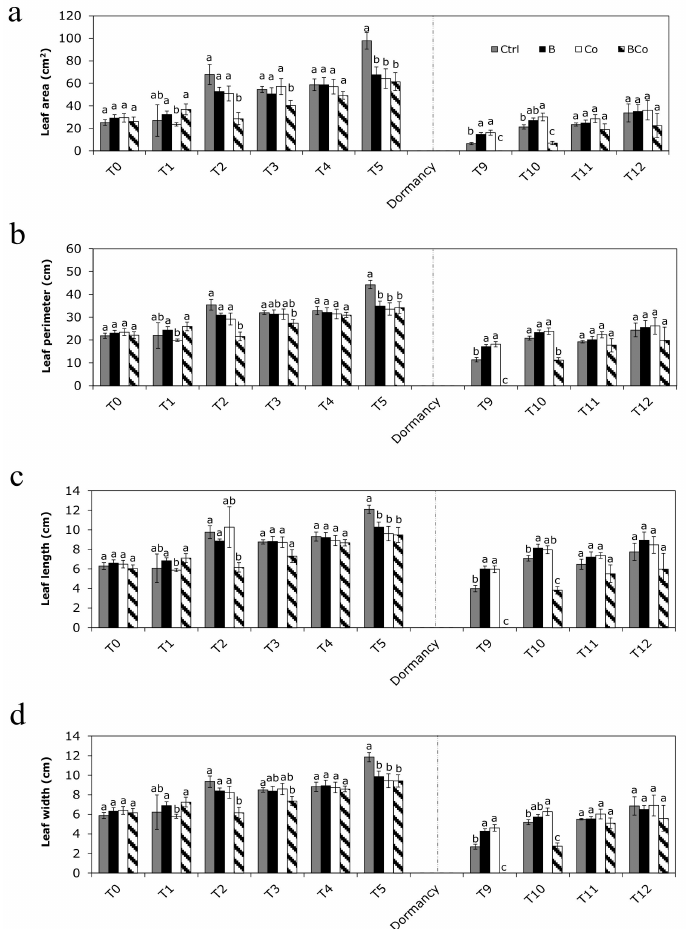
Figure 4. Leaf area ( a ), perimeter ( b ), length ( c ), and width ( d ) determined monthly during the 12 months of P. euramericana growth on four different substrates (Ctrl, B, Co, and BCo). Different letters indicate significant differences among the treatments for each sampling time ( p < 0.05) ( n = 10 ± SE). Ctrl: control mix of soil and sand; B: mix of soil and sand + biochar; Co: mix of soil and sand + compost; BCo: mix of soil and sand + biochar + compost. T0 to T12: Sampling times